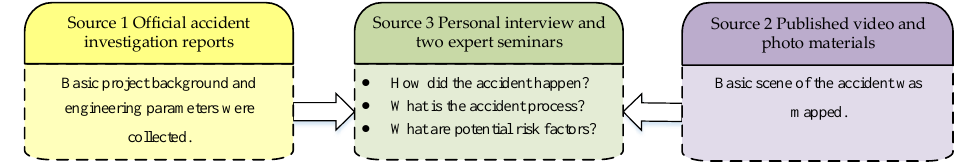
Figure 1. Data collection process of the FPCA for a case study.